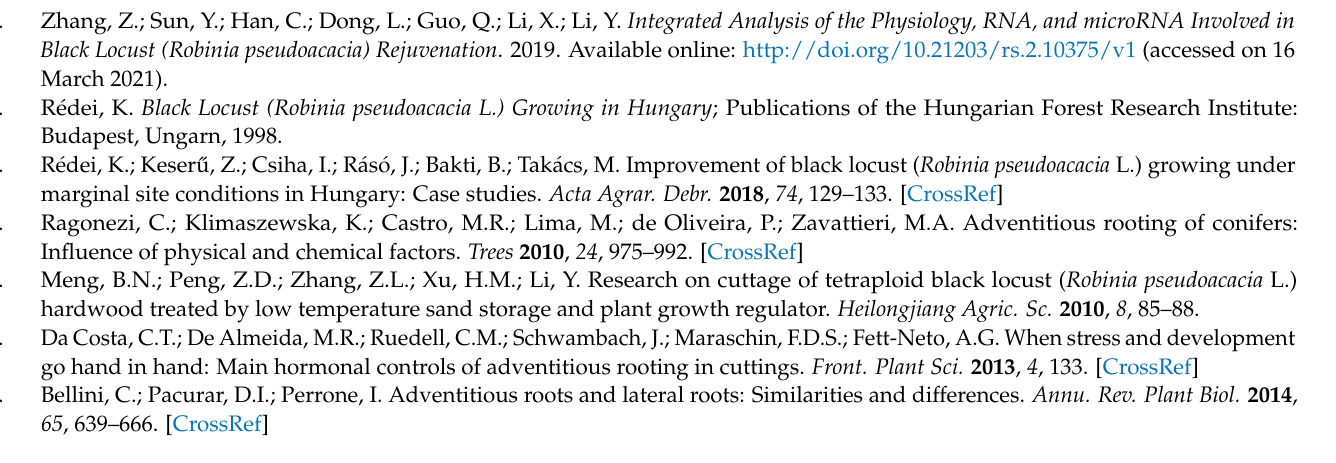
each sample, Figure S2: Correlation and principal component analysis, Figure S3: Gene ontology classification of DEGs among control and treatment and among treatment three time points, Table S1: Gene ontology classification of different comparisons, Table S2: Kyoto Encyclopedia of Genes and Genomes (KEGG) of different comparisons, Table S3: DEGs identified in different pathways at three time points with respective control (CK60, 60h, 66h, 72h) with expression values in log2(FPKM), Table S4: Sequence of primers used in the qRT-PCR analysis to validate gene